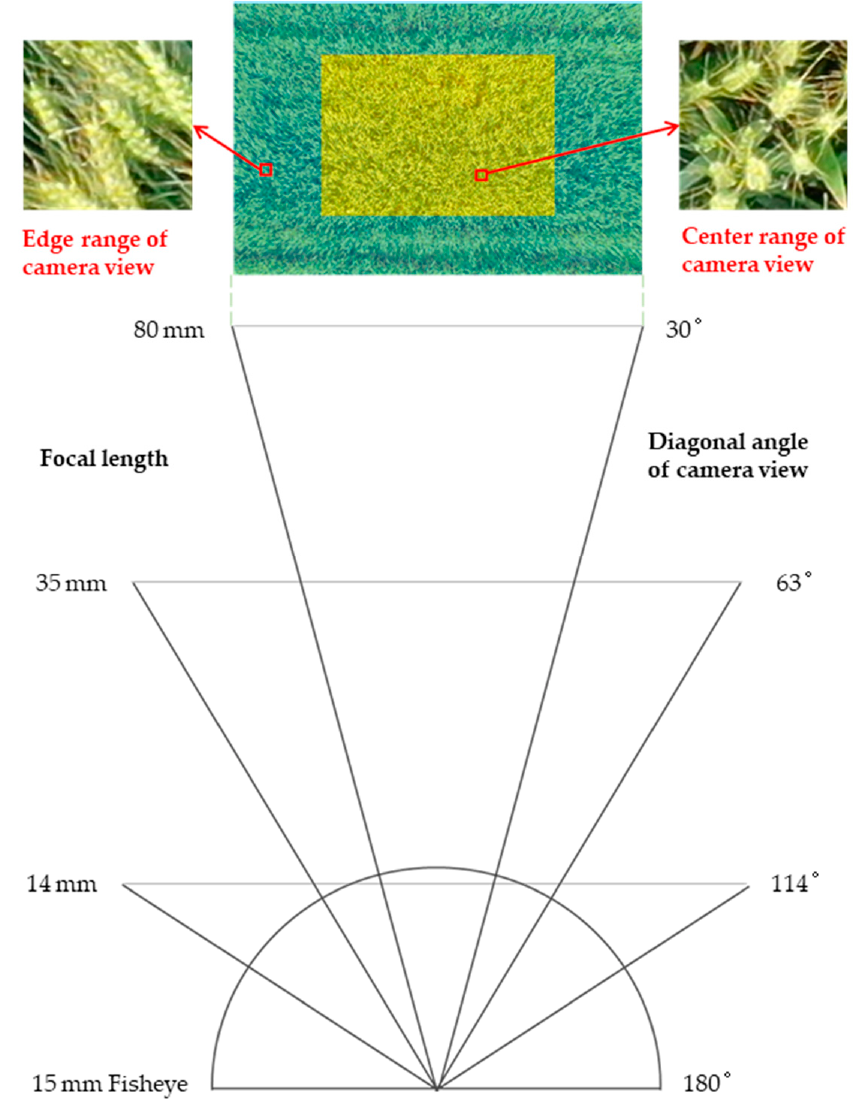
Figure 3. Differences in the characteristics of wheat ears in different camera views.